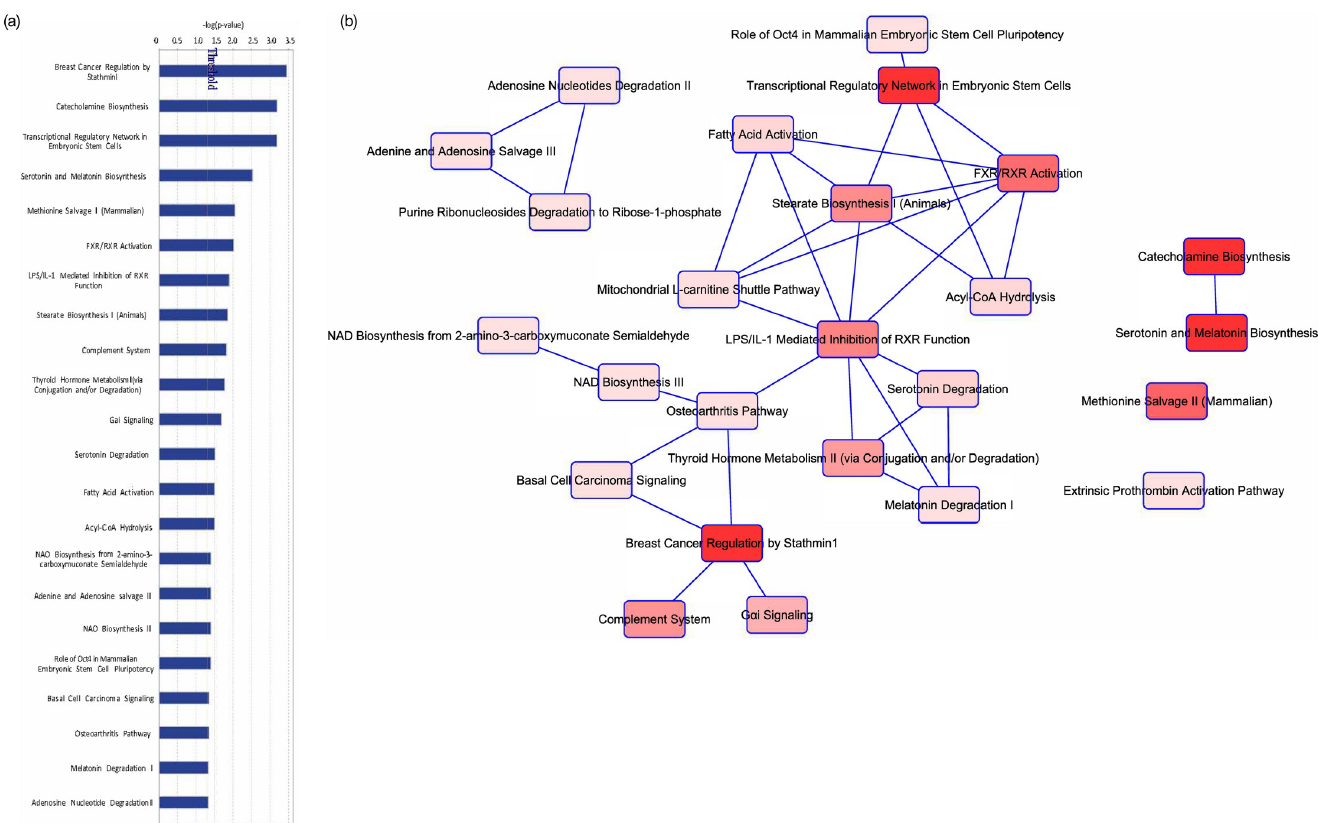
Fig 4. Differential expression analysis of DACH1 mutated versus wild-type patients. (A) Pathway analysis of genes differentially expressed between DACH1 mutated patients and wild-type. (B) Network analysis of the pathways differentially expressed between DACH1 mutated patients and wild-type.